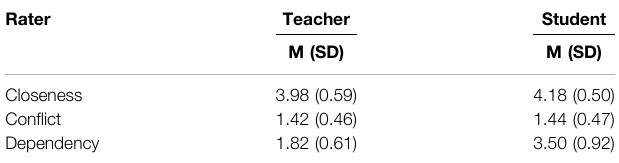
TABLE 1 | Descriptive across STRS and CARTS